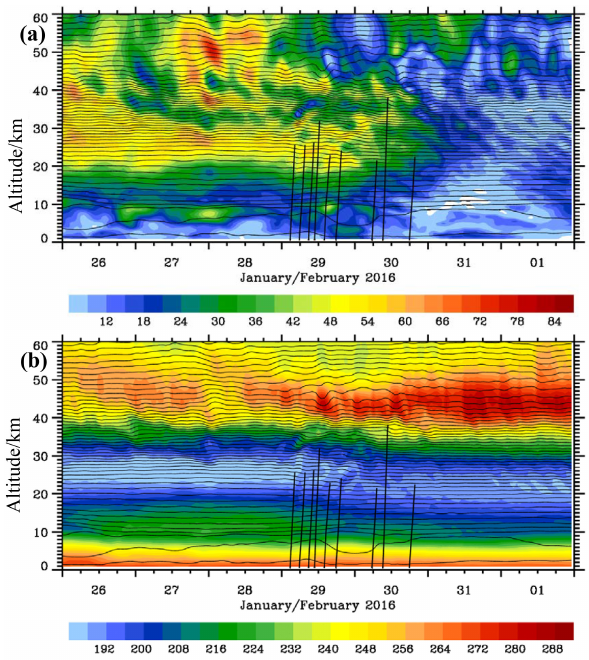
Figure 2. Altitude–time sections of the horizontal wind V H in ms − 1 (a) and the absolute temperature in K (b) as a composite of 1-hourly short-term HRES forecasts and 6-hourly operational anal- yses from the IFS cycle 41r2 above Kiruna, Sweden. The thin black lines are the logarithm of the potential temperature with constant in- crements of 0.05. The vertical black lines mark the radiosonde paths of the nine soundings mentioned in the